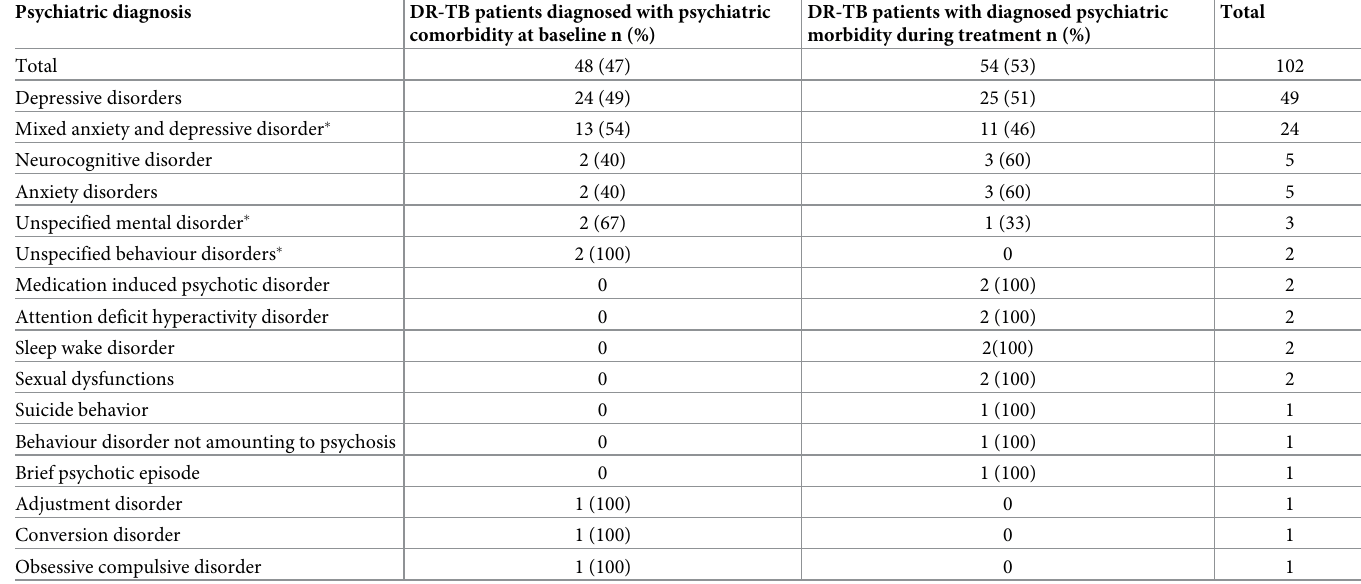
Table 2. Psychiatric diagnoses among drug-resistant tuberculosis patients enrolled at Me´decins Sans Fronti è res Mumbai clinic between January 2012 and March 2019. Psychiatric